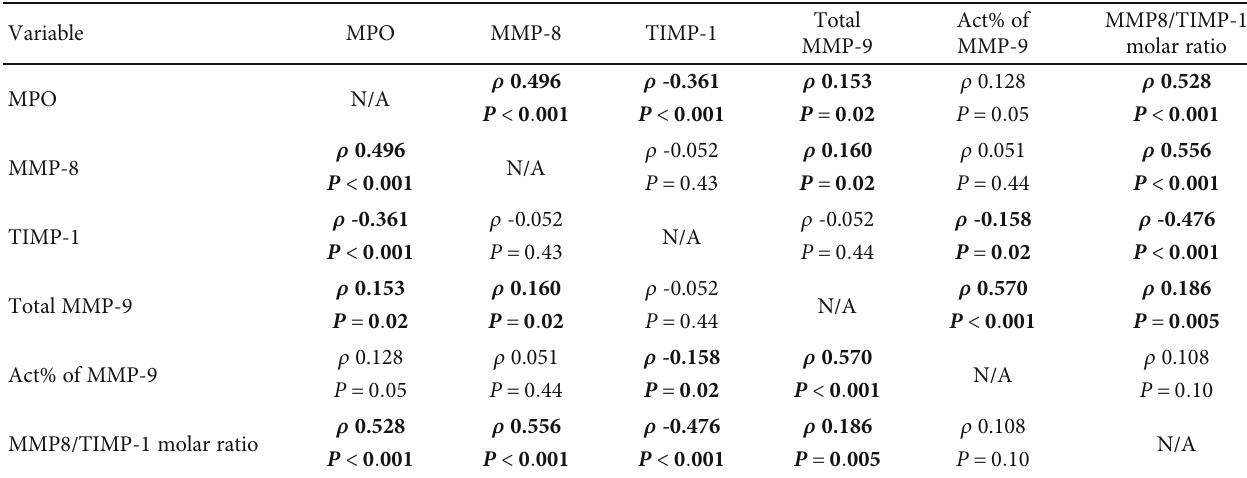
Table 3: Correlation matrix for the studied molecules a